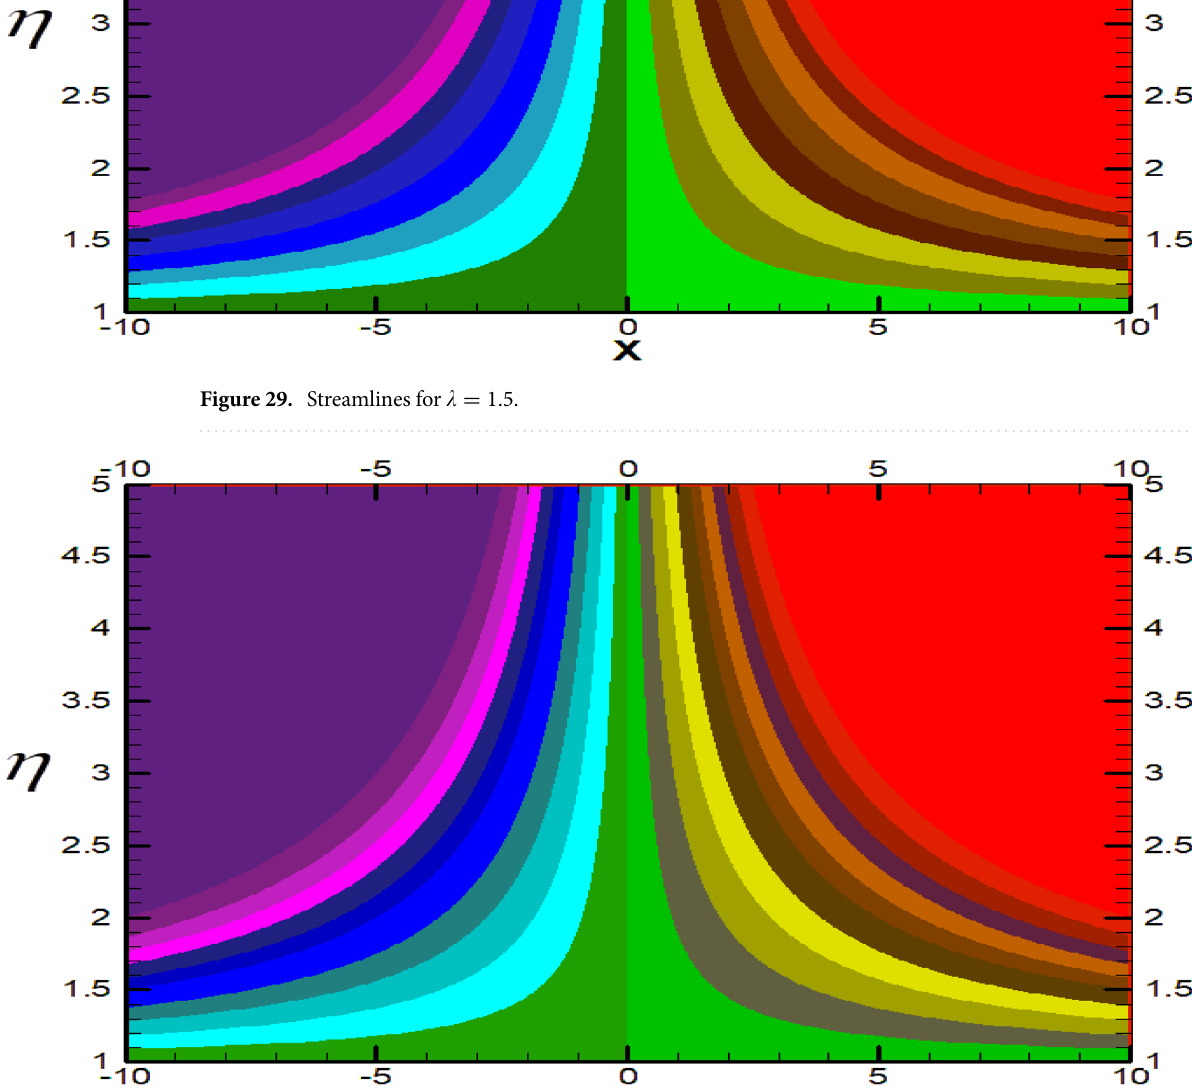
Figure 30. Streamlines for β